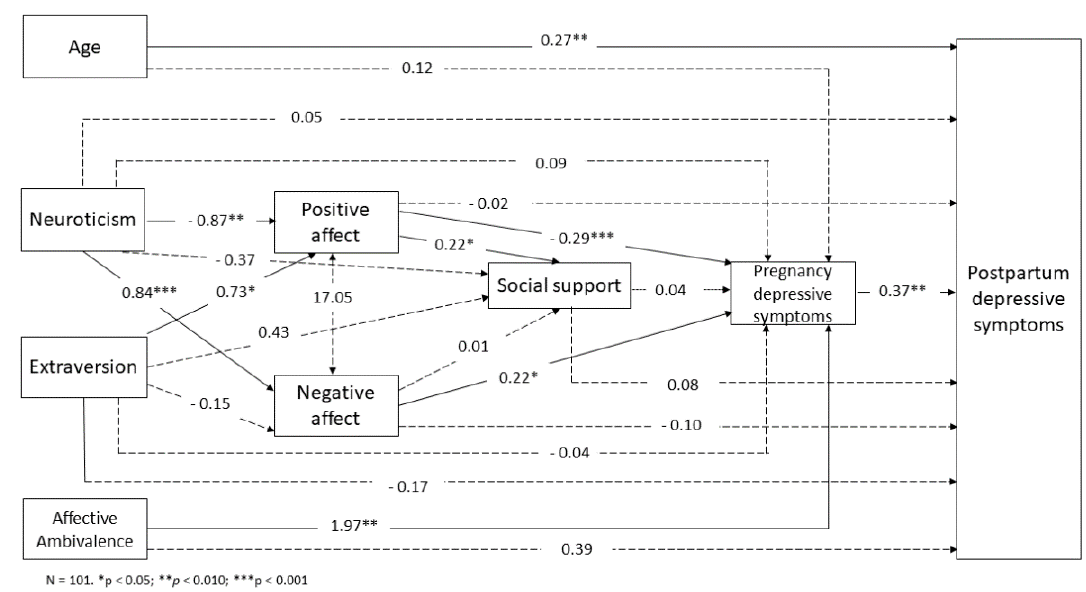
Figure 2. Structural Equation Model predicting depressive symptoms in the sample of completers.